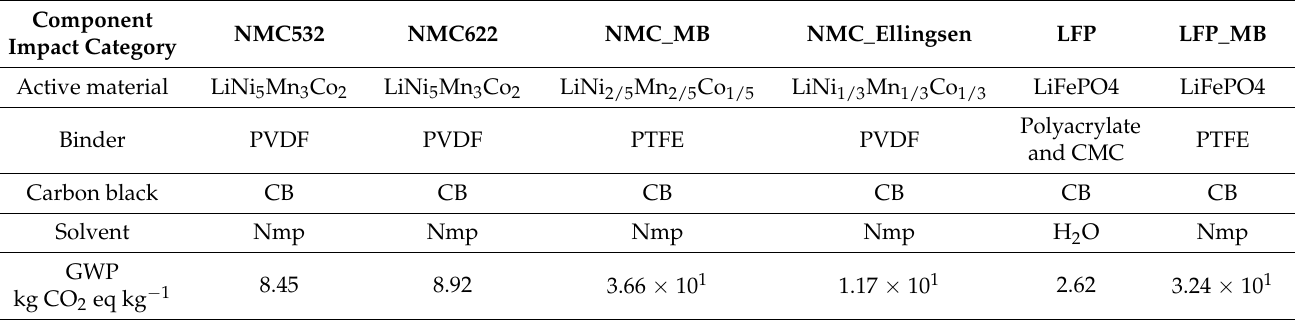
Table 5. Positive electrode material composition for different cells and climate change (kg CO 2 eq) impacts for the production of 1 kg of binder for the positive electrode (Nmp: N-methyl-2-pyrrolidone; PVDF: polyvinylidene difluoride;